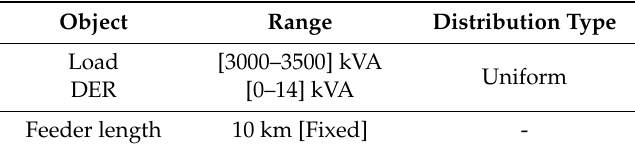
Table 5. Environment for